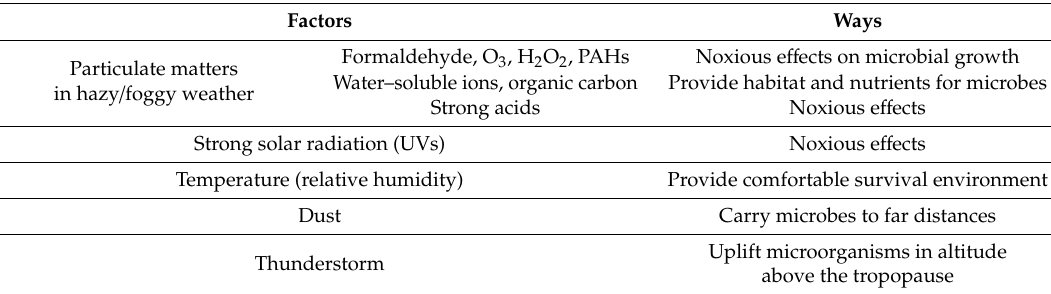
Table 2. Factors that influence the characteristics of airborne